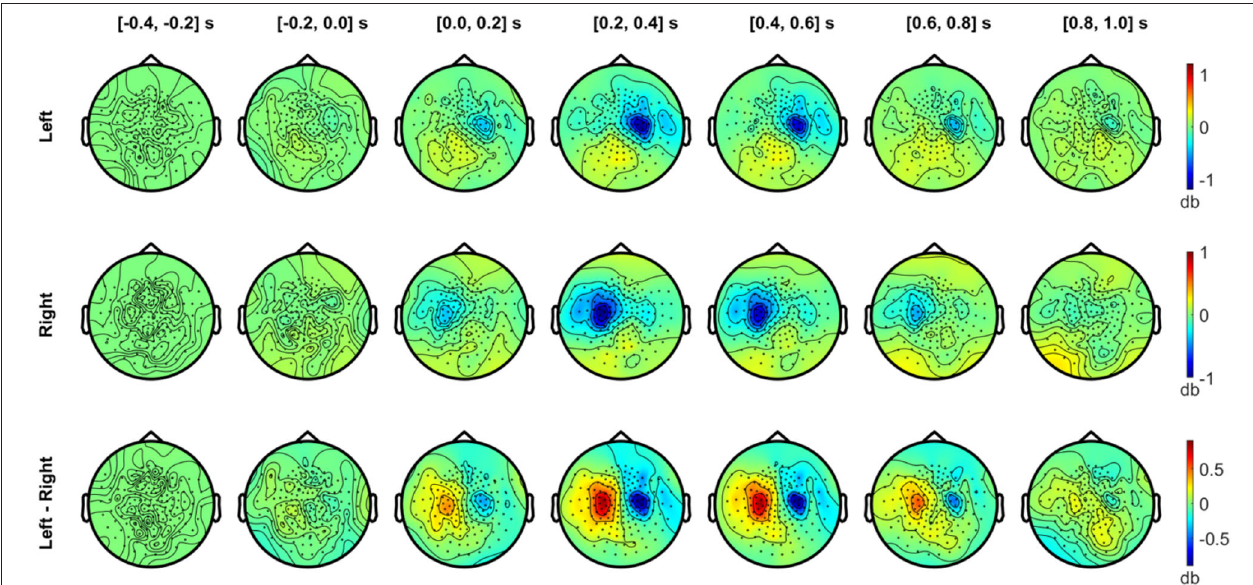
FIGURE 6 | Temporal development of topographical power distributions in the alpha band (8–12 Hz) induced by vibrotactile stimulation. The topography of spectral power change in the alpha band (8–12 Hz) relative to the baseline is plotted for every 0.2 s, between − 0.4 to 1.0 s with respect to the stimulus onset, both for the left index finger stimulation (top panel) and for the right index finger stimulation (middle panel). For both conditions, a contralateral alpha suppression (blue colors) effect is clearly observed in sensors overlying the sensorimotor regions. In the bottom panel, the difference in the alpha power between left and right stimuli is plotted. Blue areas indicate a lower alpha activity in the left index finger stimulation compared with the right index finger stimulation, and vice versa for red areas. All plots are obtained for planar gradiometers.